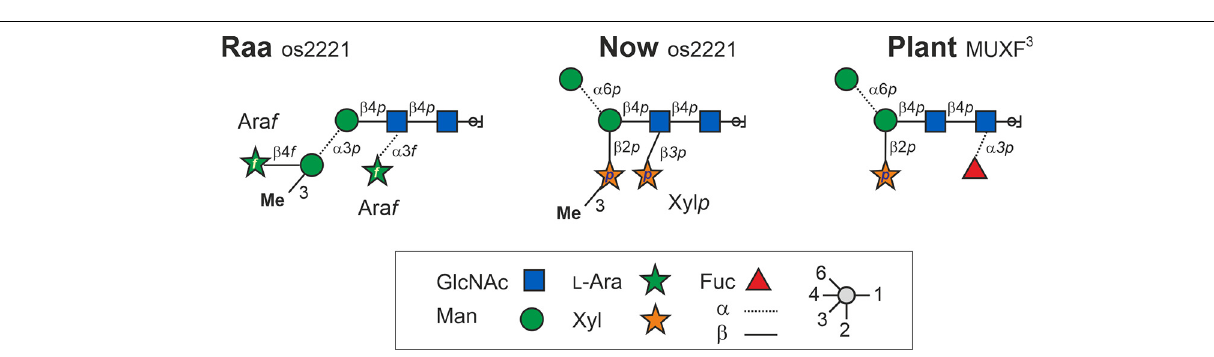
FIGURE 6 | Structures of the major N -glycans found in sample C-76 (“Raa” type) and C-5 (“Now” type) both having the mass 1,026.3 Da. Os2221 indicates the oligosaccharides’ numbers of hexoses, HexNAc, pentoses, and methyl groups, respectively. Bromelain MUXF 3 depicted for